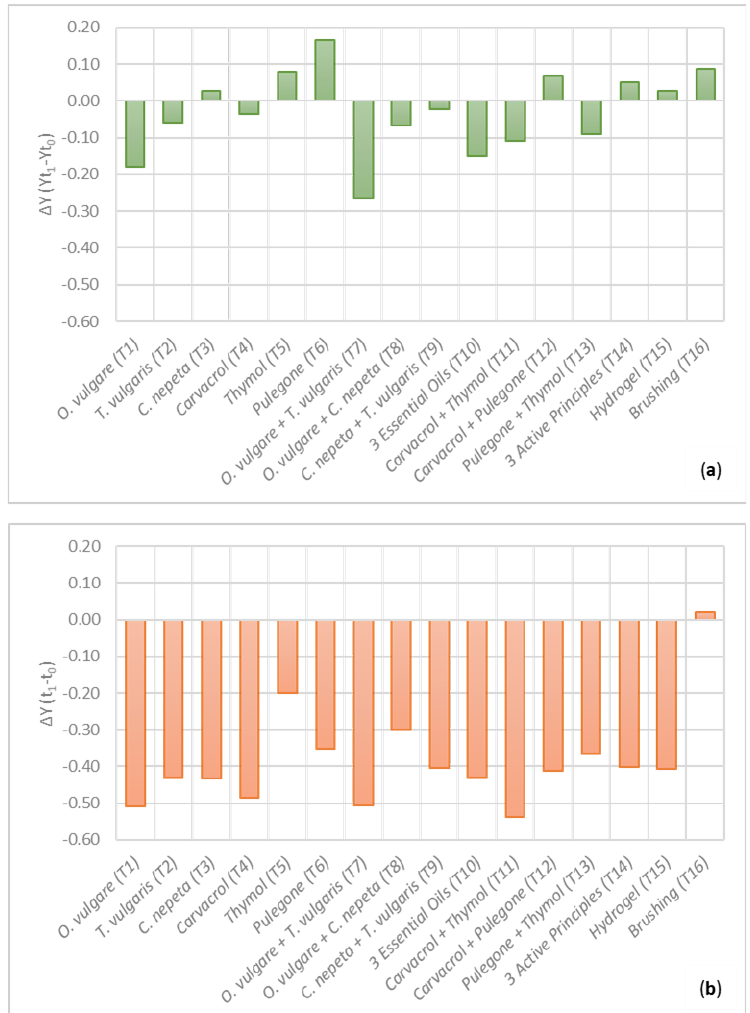
Figure 8. Relative differences (ΔY) of maximum quantum yield (Y) calculated between t 0 and t 1 for ( a ) Surface a, and ( b ) Surface b. ∆Y > 0 establishes the increase in the vital activity after the applica- tion of the treatments; ∆Y < 0 is the decrease in the vital activity.